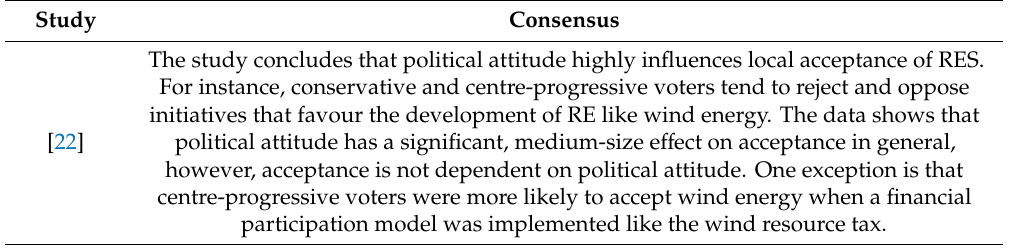
Table 5. Comparing the results of the e ff ect of socio-demographic factors on social